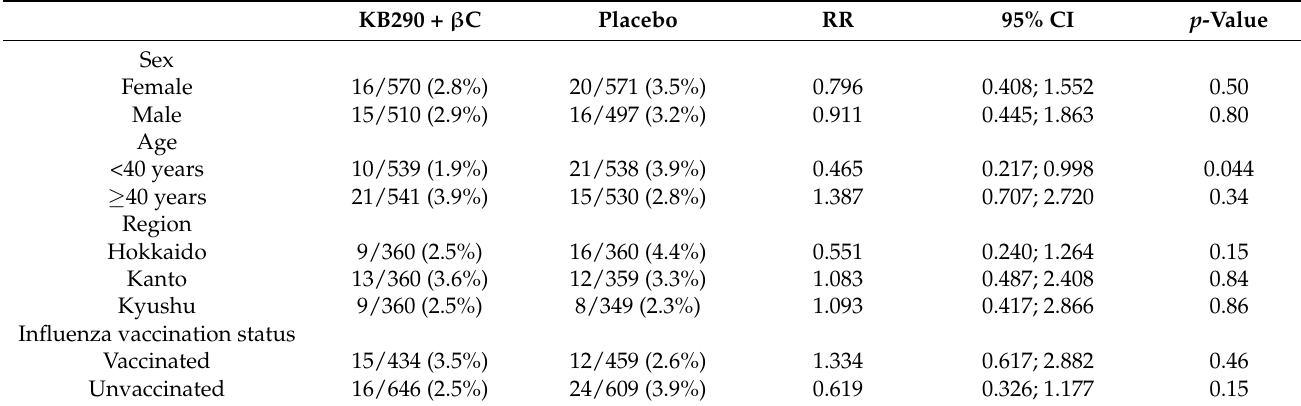
Table 3. Influenza incidence as the primary endpoint, sub-grouped according to factors 1 .